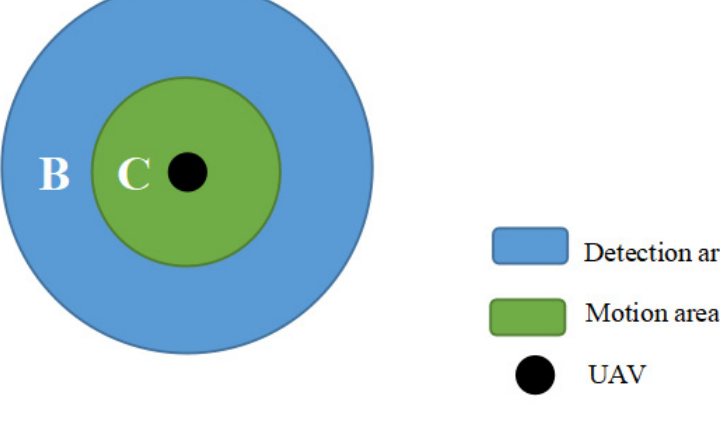
Figure 1. Abstract expression of UAV area.